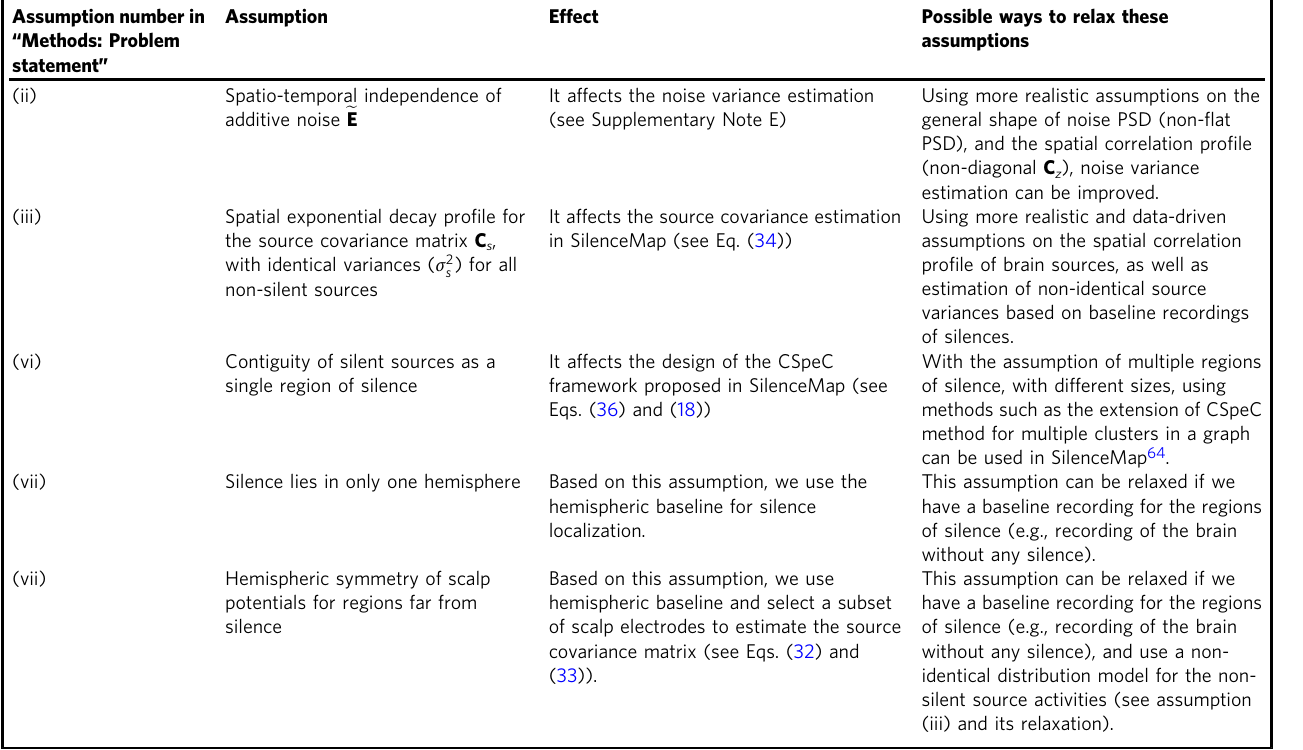
Table 3 List of simpli fi cation assumptions and their effects on silence